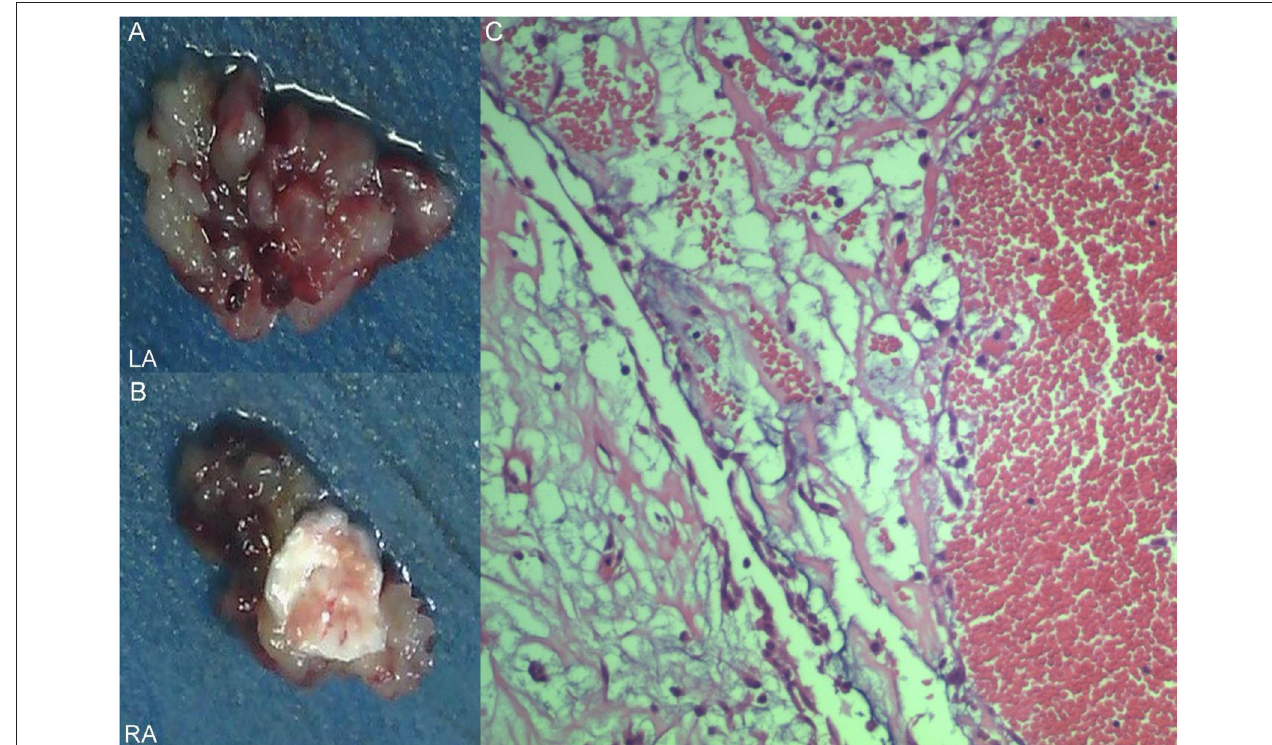
FIGURE 4 | Excised villous biatrial atrial myxoma (A,B) and histology of atrial myxoma. Acid-mucopolysaccharide matrix with characteristic astrocytes and spindle cells which have ovoid nuclei and are surrounded by thin-walled capillaries (Hematoxylin and Eosin, × 200) (C)